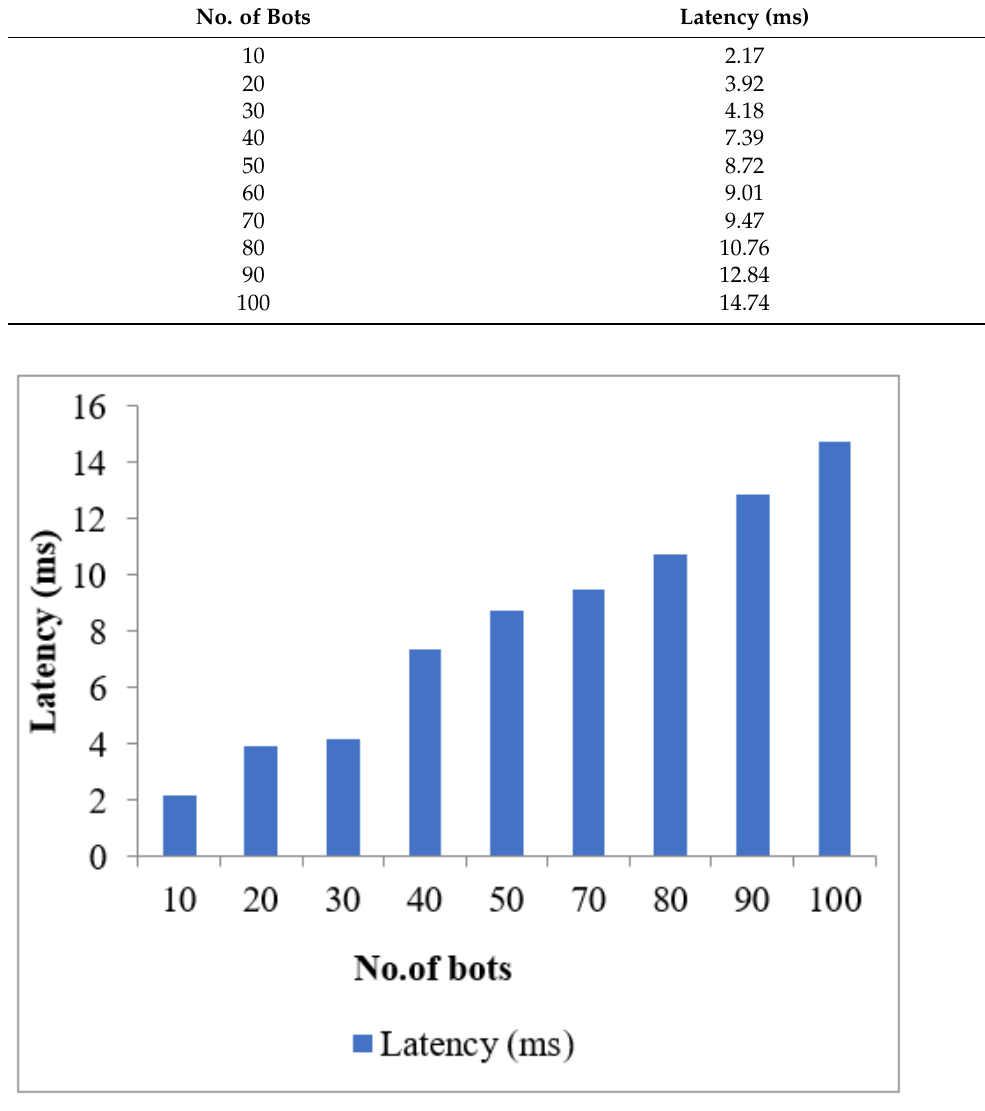
Figure 5. Graphical illustration of latency analysis.